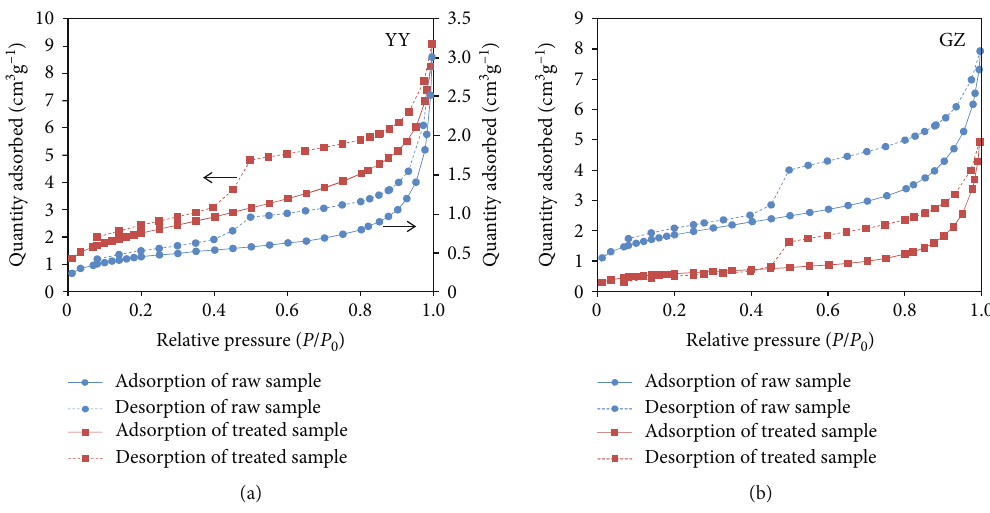
Figure 6: Low-temperature N adsorption-desorption isotherms of the two shale samples before and after reaction: (a) YY (arrows 2 correspond to the ordinate); (b) GZ. Table 4: Pore structure parameters of the shale samples before and after slick water treatment.